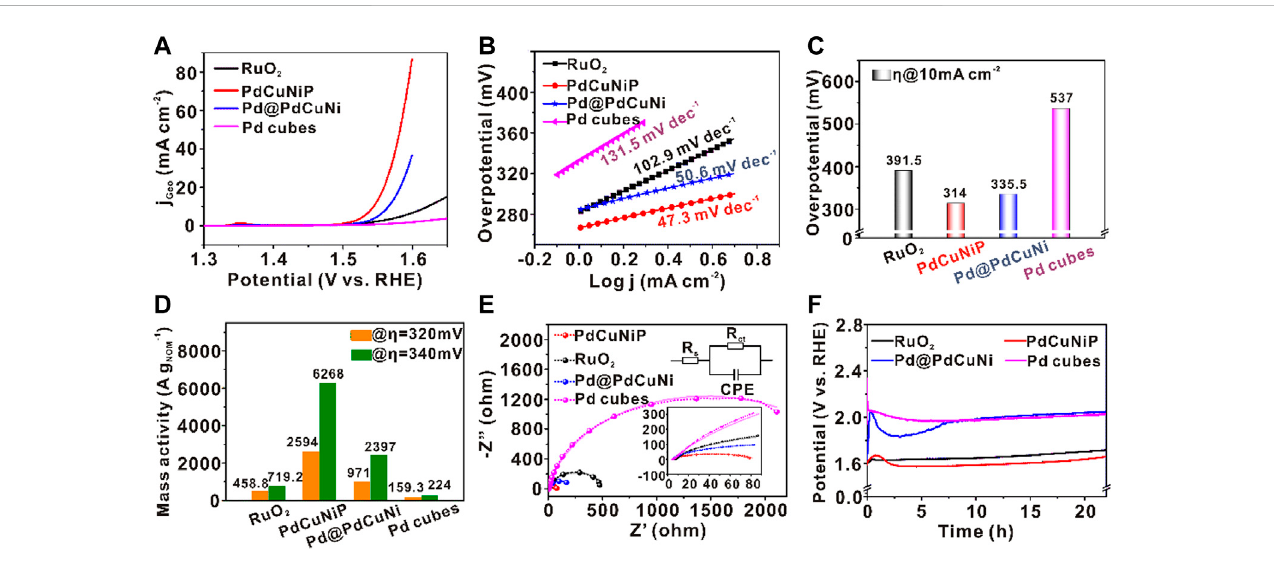
FIGURE 3 (A) LSV curves of PdCuNiP, Pd@PdCuNi, Pd nanocubes and commercial RuO (A) . (C) Comparison of the overpotentials among PdCuNiP, Pd@PdCuNi, Pd nanocubes, and commercial RuO overpotentials of 320 and 340 mV. (E) Nyquist plots of different catalysts. (F) Chronopotentiometry test of all catalysts for 22 h at the current densities of 10 mA cm − 2